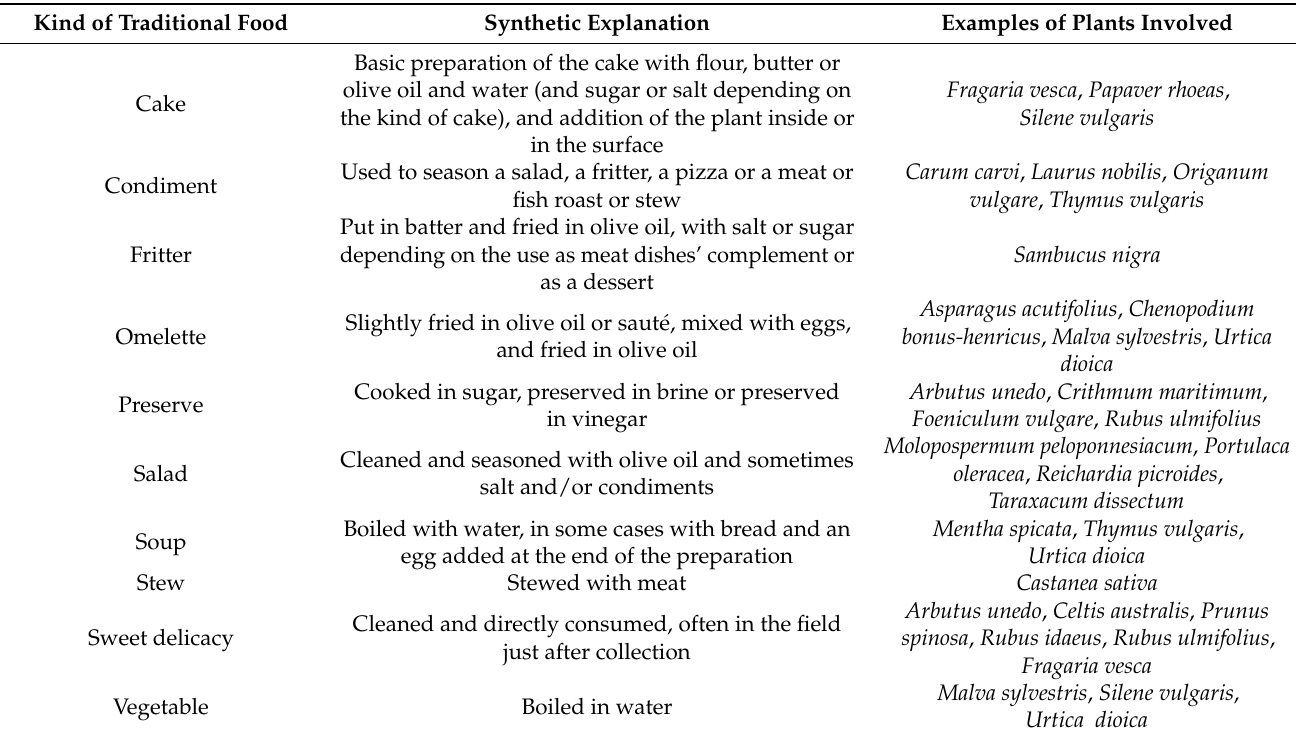
Table 2. The 10 main kinds of traditional foods and examples of wild food plants involved in each case. Kind of Traditional